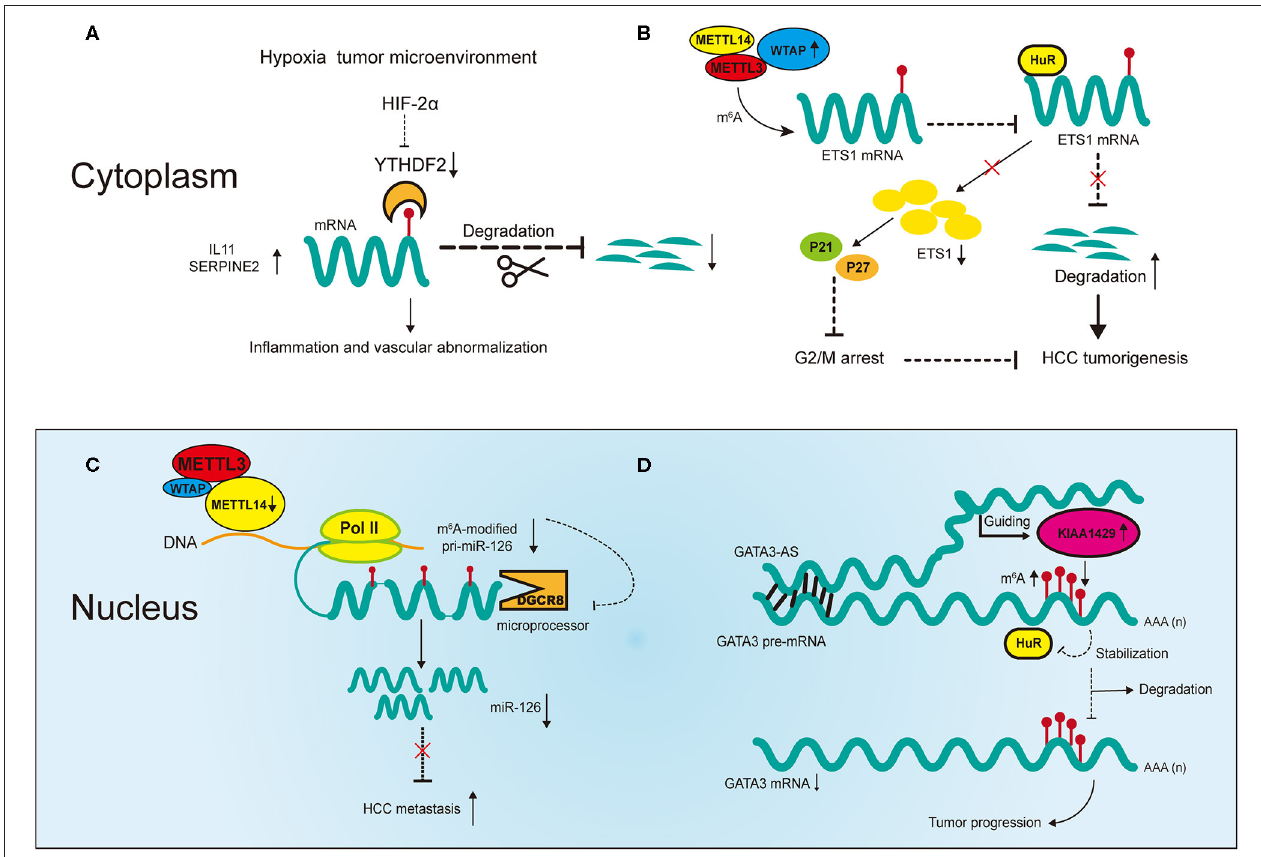
FIGURE 2 | Partial m 6 A regulatory mechanisms involved in messenger RNAs (mRNAs) and noncoding RNAs (ncRNAs) in HCC. (A) The hypoxia tumor microenvironment negatively regulates YTHDF2 to promote cancer inflammation and vascular abnormalization. (B) Upregulated WTAP promotes HCC tumorigenesis by destabilizing its targeted mRNAs in an m 6 A-dependent manner. (C) Downregulated METTL14 promotes HCC metastasis by inhibiting microRNA 126 (miRNA) maturation in an m 6 A-dependent manner. (D) Upregulated KIAA1429 promotes HCC progression in an m 6 A- and lncRNA-dependent